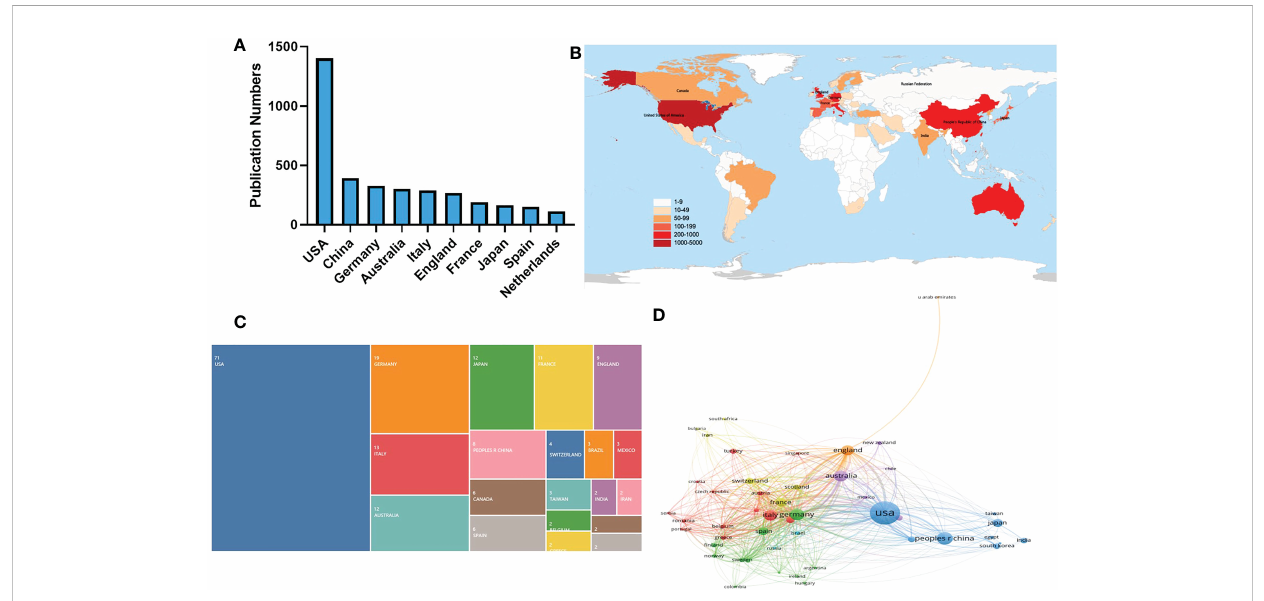
FIGURE 2 Published literature in countries/regions. (A) .The distribution trend of the top 10 countries/regions. (B) .Global map of countries/regions contributing to CSCC. (C) . National sequencing of CSCC cell programmed death studies. (D) Cooperation between countries in the CSCC fi eld.